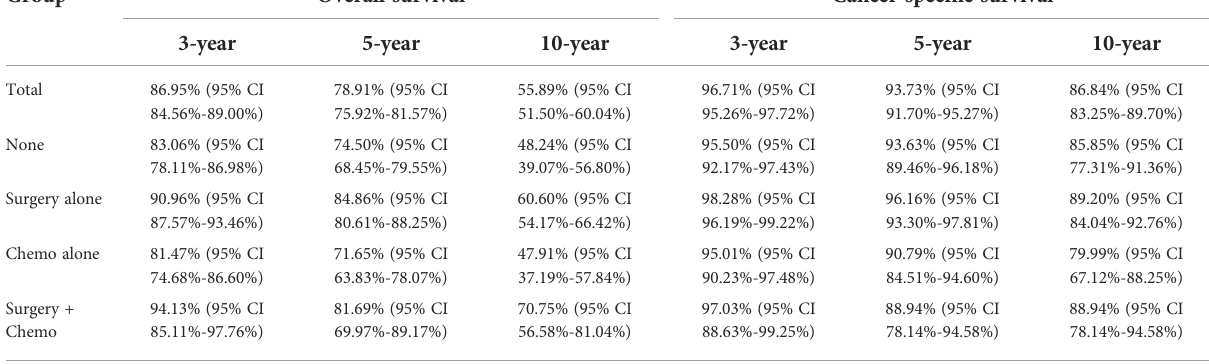
TABLE 2 Unadjusted Survival Estimates.